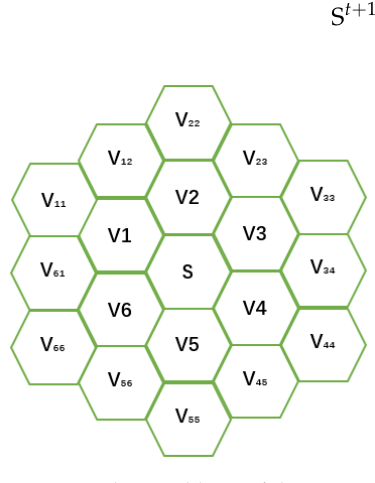
Figure 1. The neighbors of the CA model.